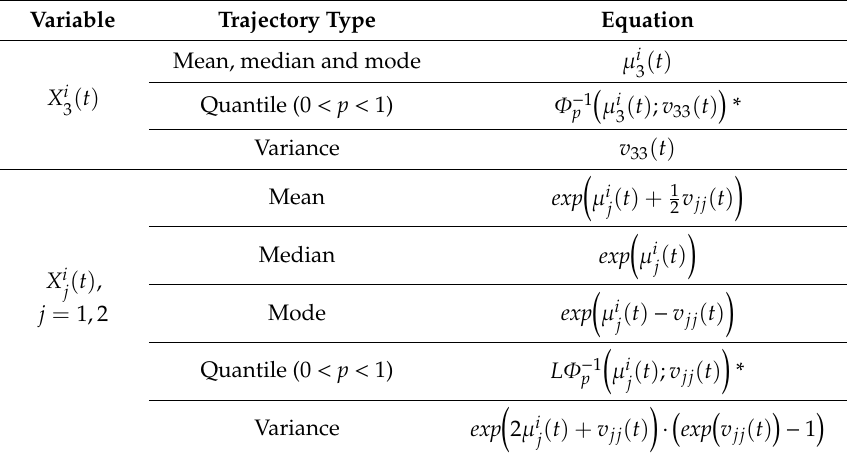
Table 1. Marginal mean, median, mode, p -quantile (0 < p < 1), and variance